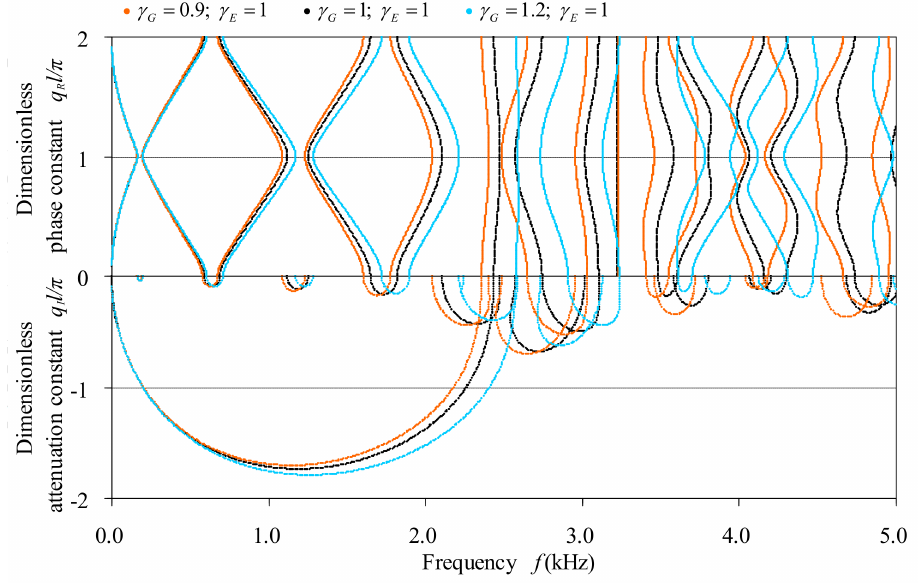
Figure 12. Effect of the Poisson’s ratio of constituent beam as its Young’s modulus remains on the band structures in the bi-coupled periodic beam with Ternary-I unit